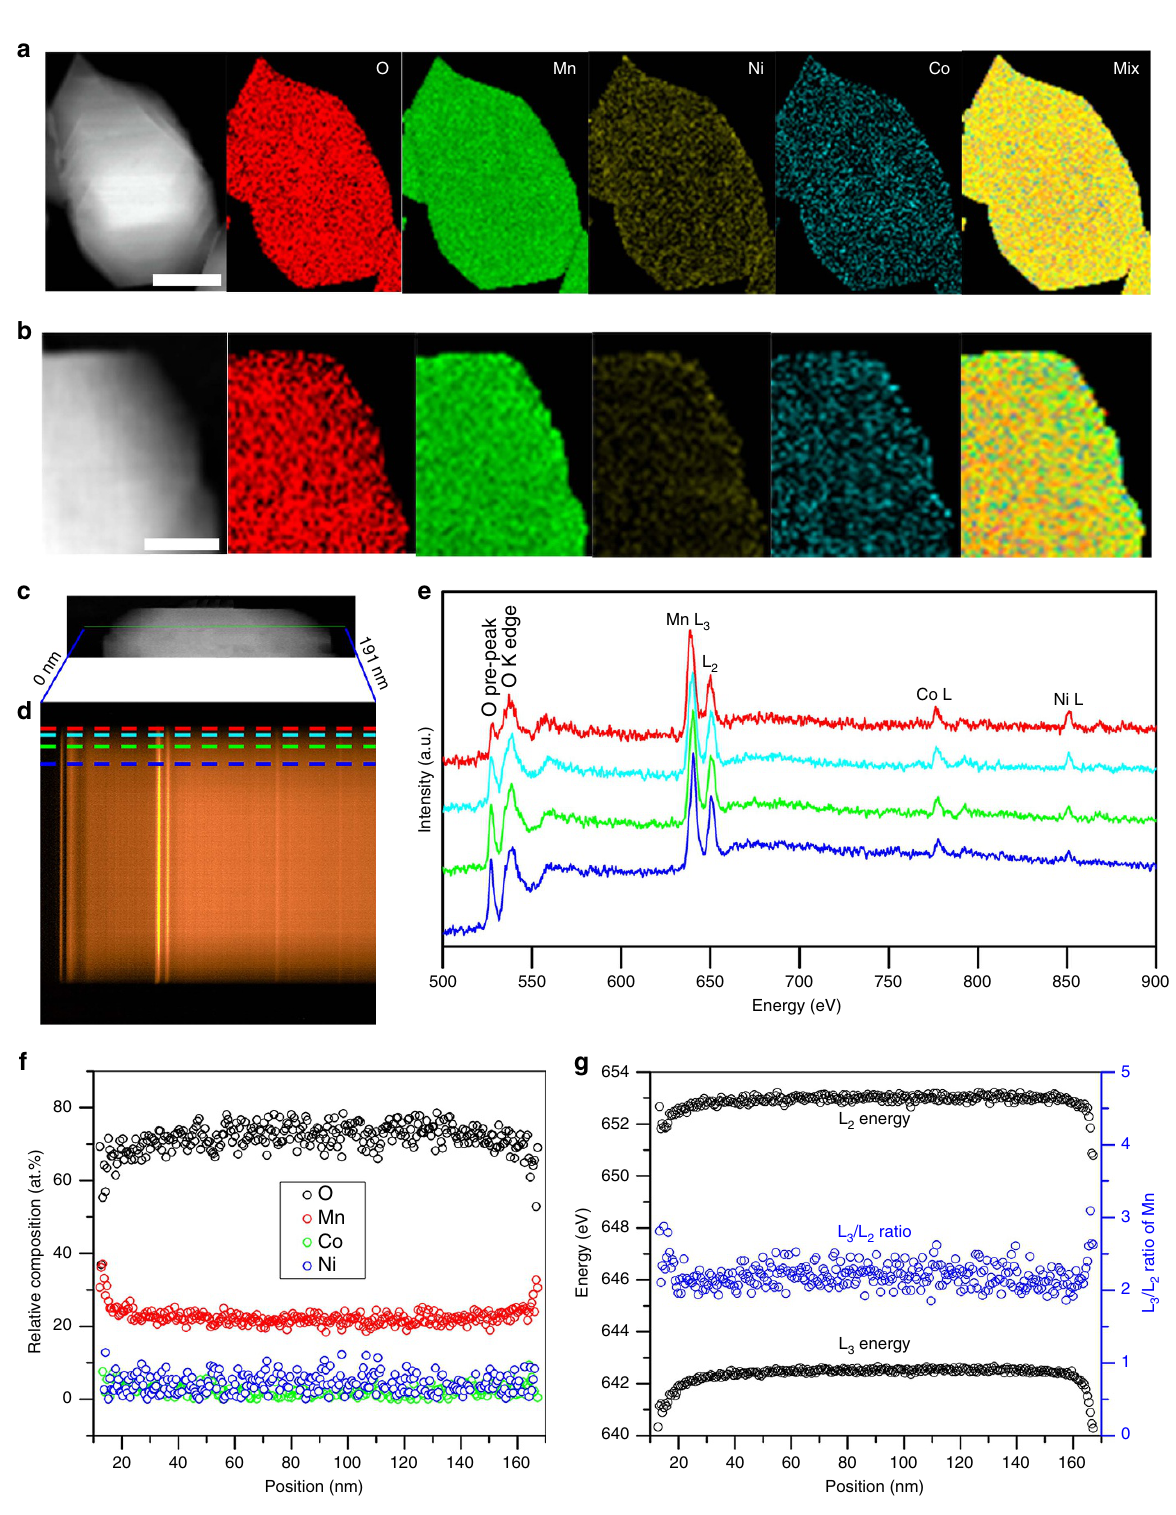
Figure 3 | Relative surface composition changes for the pristine and GSIR LR-NCM. ( a ) STEM-EELS spectrum images for the pristine LR-NCM. Scale bar, 50nm. ( b ) The GSIR LR-NCM. Scale bar, 25nm. Oxygen reduction at mixed colour images is well-demonstrated on the edge in comparison with the pristine LR-NCM ( a ). ( c ) STEM image of a particle of the GSIR LR-NCM. ( d ) EELS spectrum image from the vertical green line (0–191nm) in the left STEM image ( c ), showing O K, Mn L 2, 3 , Co L 2, 3 , Ni L 2, 3 edges. The dispersion is 0.25eV/channel. The scan step is 0.127nm. ( e ) EELS spectrum profiles from the surface to the interior as marked by the horizontal dashed lines with the same colour as in d . The spectra are normalized with Mn L 3 peak, and each spectrum was averaged vertically with 10 individual spectra to improve the signal noise ratio. Weak O pre-peak on the surface indicates the oxygen vacancies are formed. ( f ) Relative atomic composition of O (black), Mn (red), Co (blue) and Ni (green) as a function of position calculated based on the integrated EELS peak intensity in e . ( g ) Mn L 3 , and L 2 energy (top and bottom of panel) from refinement, and L 3 /L 2 intensity ratio.